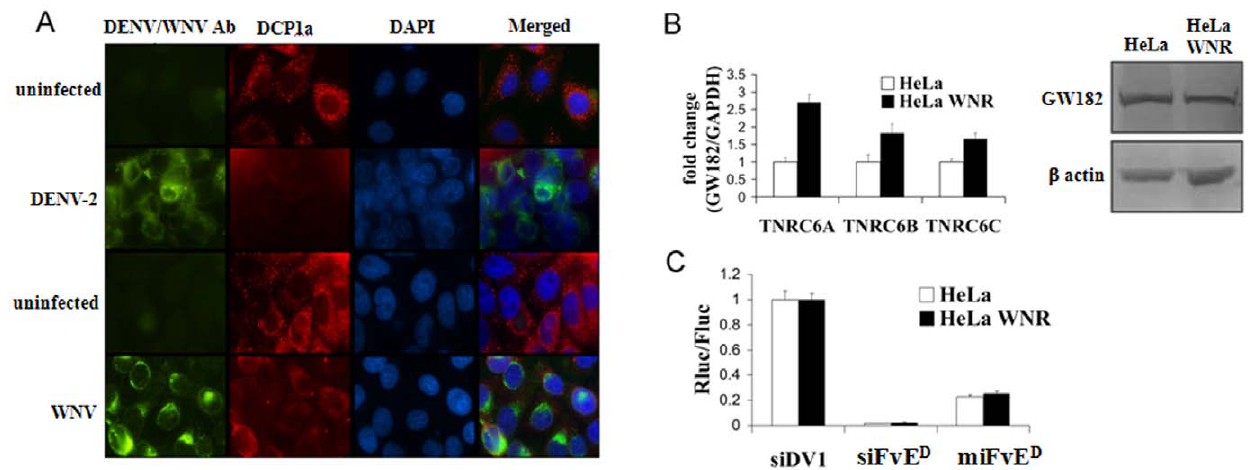
Figure 3. Flavivirally infected cells lose microscopic P bodies, but not GW182 and exhibit both si and miRNA-mediated target repression. A) Uninfected and dengue or West Nile virus infected HeLa cells were stained with DAPI, DCP1a and dengue/WNV antibody and examined for P bodies by microscopy. B) Control HeLa cells and HeLa cells expressing WNV replicon (HeLa WNR) were tested for GW182 isoform expression at mRNA level by QRT-PCR (left) and protein level by Western blot (right). C) West Nile replicon expressing HeLa cells were transfected with luciferase reporter with si/miRNA and analyzed as in Fig 1a. siDV1 represents control irrelevant siRNA. Error bars represent mean of quadruplicates + / 2